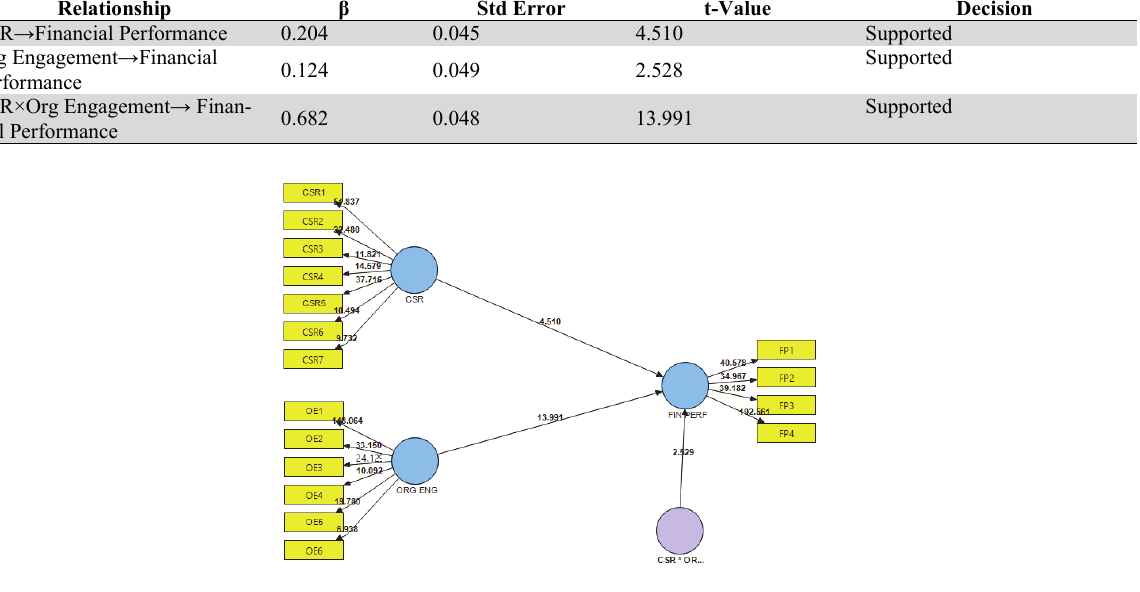
Fig. 2. Structural Model- Moderation